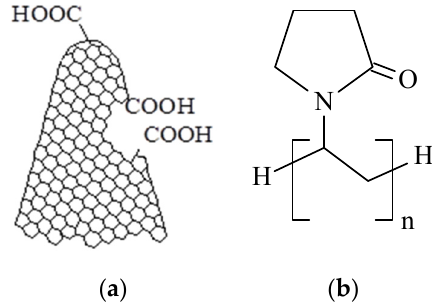
Figure 1. The structure of ( a ) holey carbon nanohorns—CNHox, ( b ) PVP. Preparation of the quaternary organic–inorganic—holeycarbon nanohorns hybrid sens- ing films and the experimental setup are described in detail in the supplementary